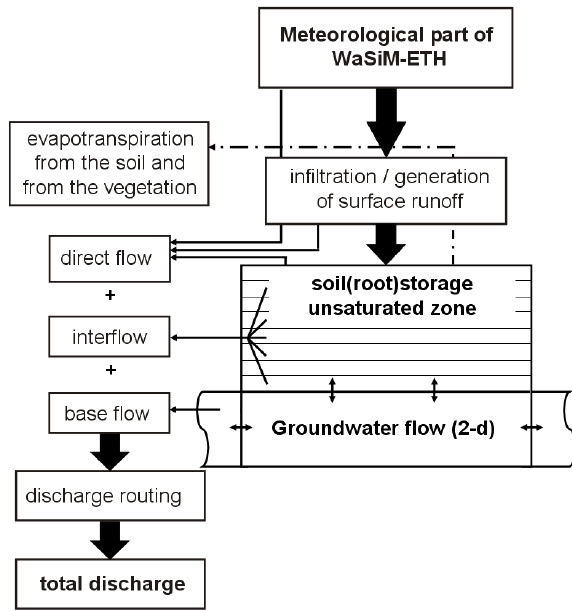
Fig. 1. Flow chart diagram of the WaSiM-ETH model